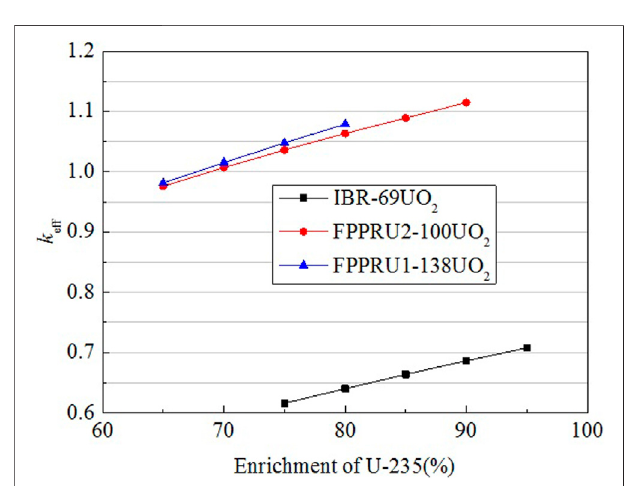
FIGURE 11 | Changes of the maximum